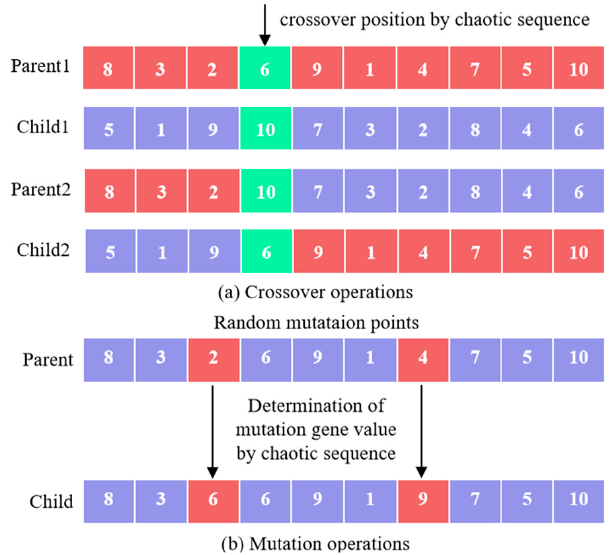
Figure 8. Crossover and mutation operation.